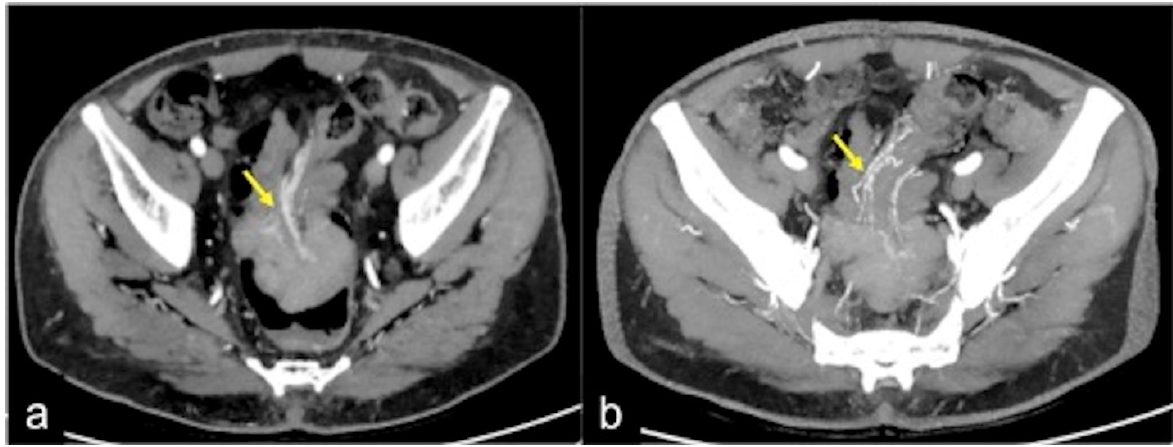
Figure 38. CTA multiphasic study in the arterial phase ( a ) and MIP reconstruction ( b ); an invaginated polyp in the sigmoid colon with arterial vascular support is visible (arrow ( a , b )).